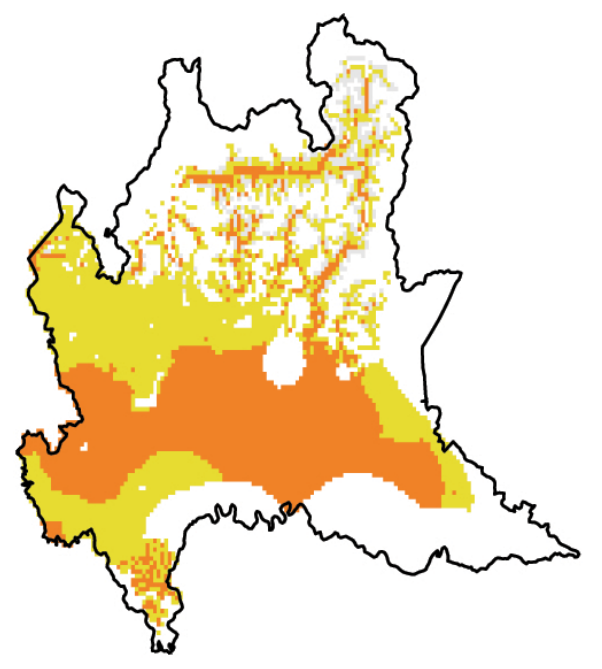
Figure 6. 22 June 2012. TX extreme events classification. Extreme warming: orange. Unusual warming: yellow. Normal conditions: grey. The IDI mask has been applied (see Sect.